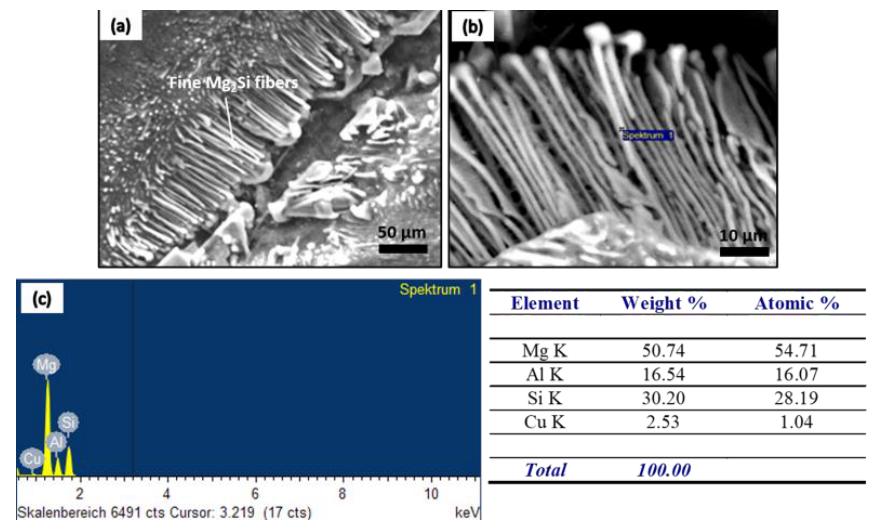
Figure 10. ( a , b ) SEM SE images taken from the deep-etched sample, which confirm the fibrous morphology of Mg 2 Si in the Al-13.1 wt.% Mg 2 Si-200 ppm P alloy along with ( c ) the EDS spectrum of elements from the selected point, as marked in ( b ).